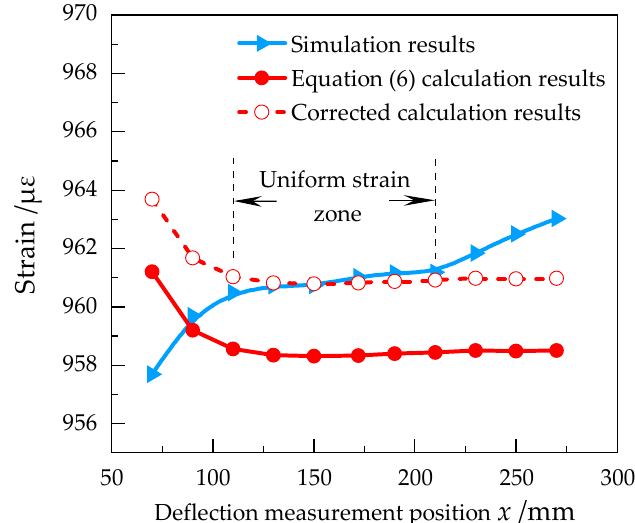
Figure 3. The strain simulation results at different positions with 100 N load, the calculation results of Equation (6), and the corrected calculation results of Equation (6). Table 4. Strain difference before and after correction with a load of 100